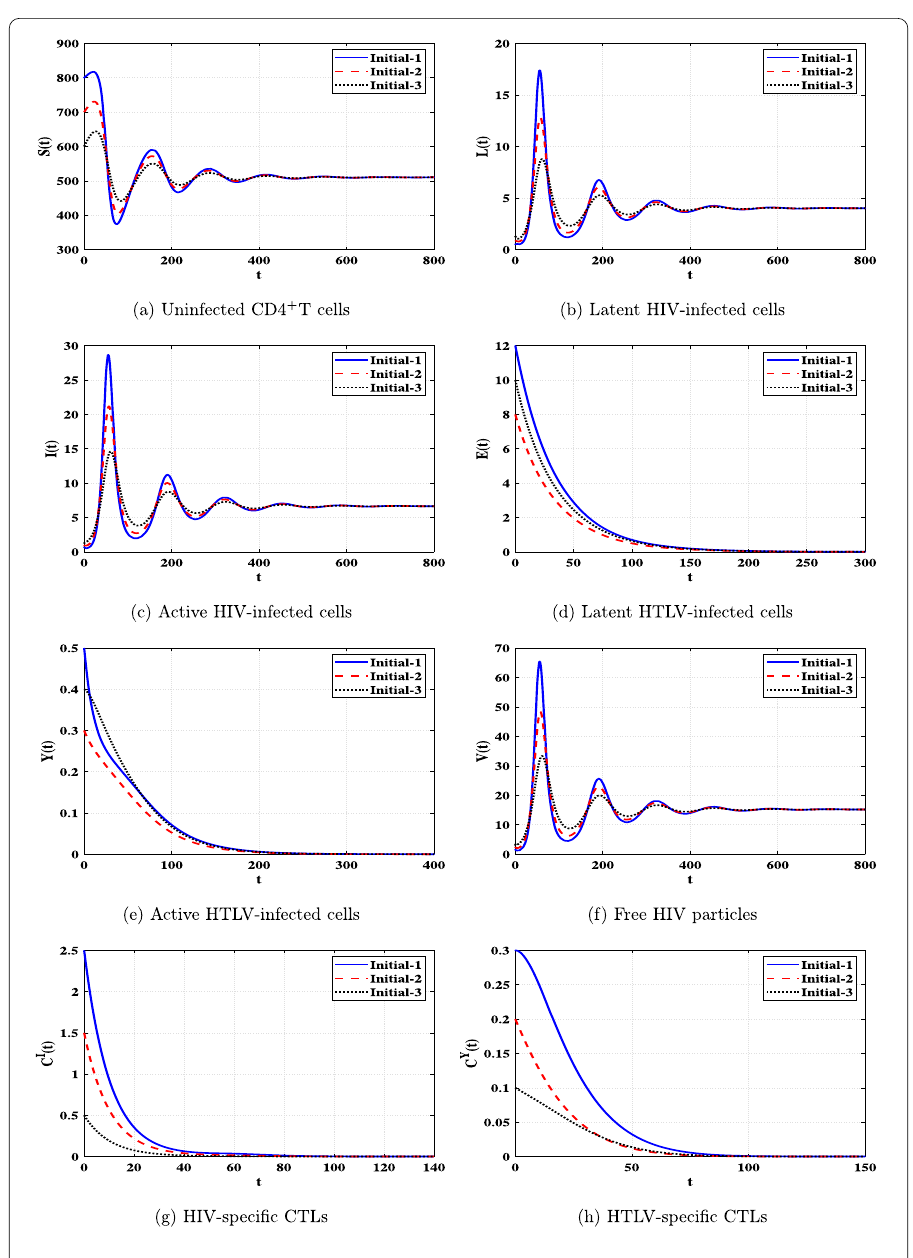
Figure 2 Solutions of system (29) when (cid:9) 1 > 1, (cid:9) 2 / (cid:9) 1 ≤ 1, and (cid:9) 3 ≤ 1